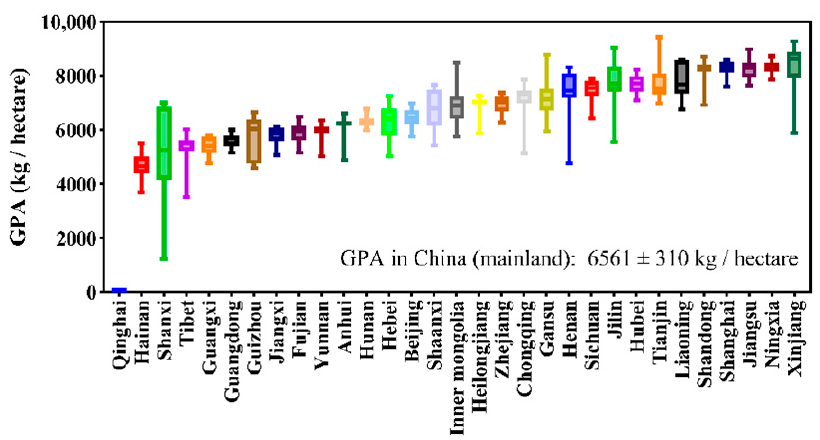
Figure 9. Grain yield per unit planting area in rice in different provinces in the recent 20 years. Error bars are the maximum and minimum values.